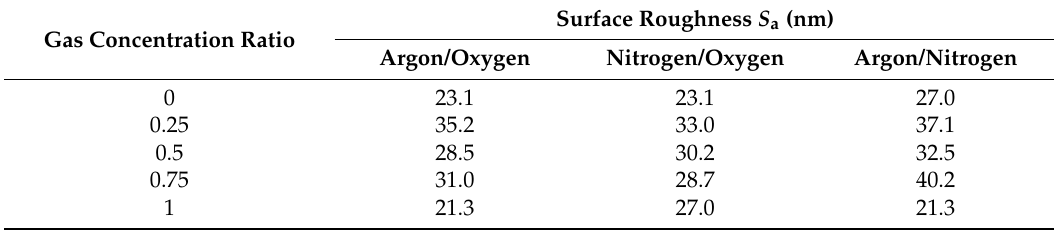
Table 3. Surface roughness of plasma treated LDPE using different gas mixtures at 120